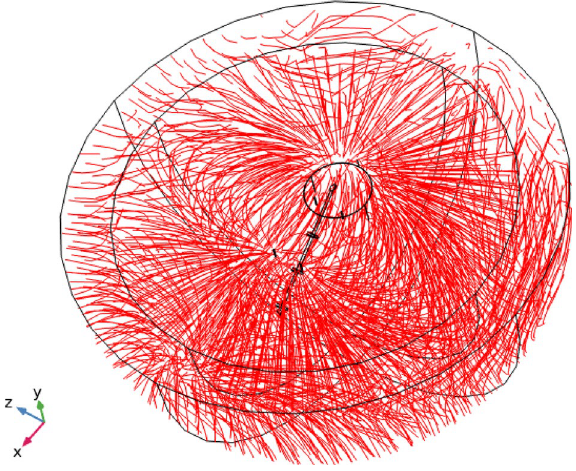
Figure 11. Streamlines of cathodic protection current in the soil after 30